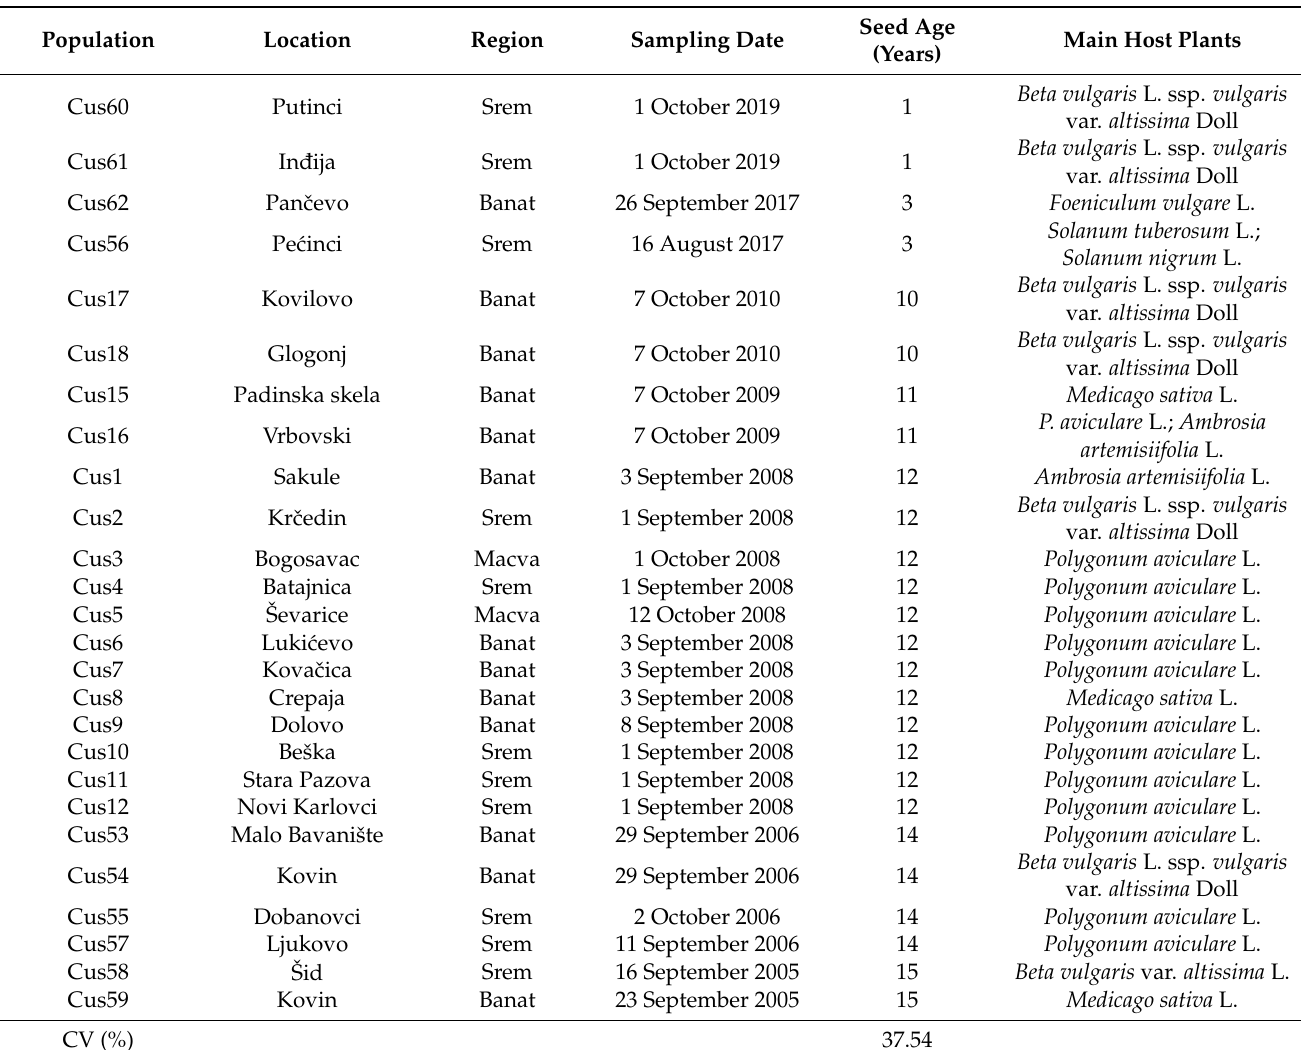
Table 1. Primary data on seed materials (voucher